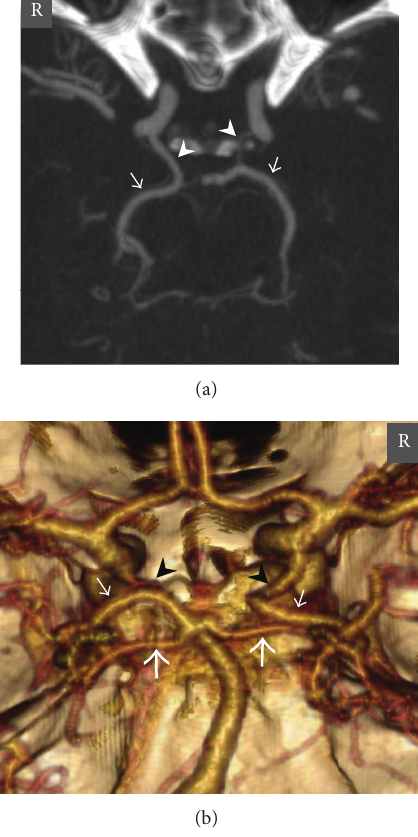
Figure 6: Axial MIP (a) and posteroanterior view VR (b) CT angiography images show a right PCA with fetal origin in a 42-year- old man. The P1 segment of the right PCA is agenetic, and there is a well-developed right PCoA that supplies the P2 and distal segments of the right PCA. The P1 segment of the left PCA is patent, and there is a thin calibrated left PCoA. Thick short arrows = right and left SCAs, thin short arrows = right and left PCAs, arrowheads = right and left PCoAs, and R =